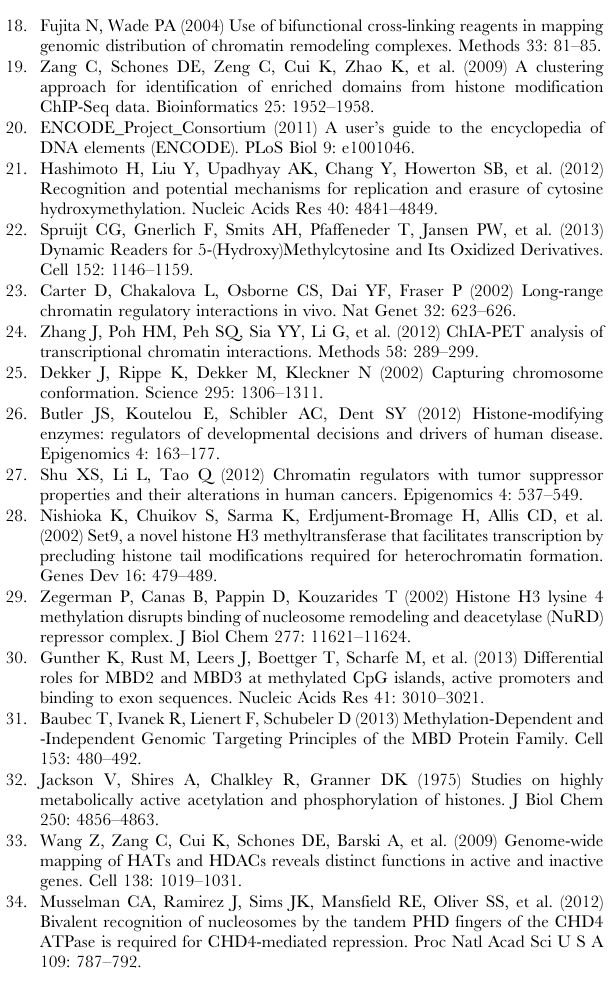
Table S5 Quality control of MBD3 ChIP-seq data. Ours